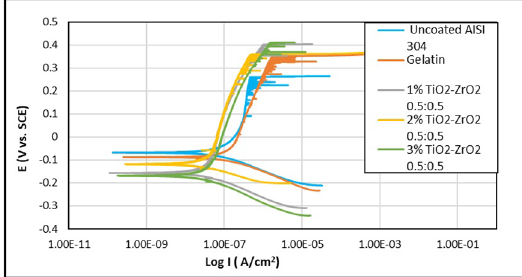
Figure 9. The potentiodynamic polarization curves of the AISI 304 steel coated with hybrid TiO -ZrO coating with mix ratio 0.5:0.5 2 2 and different weight percentages (1% wt., 2% wt., 3% wt.) of nanoparticles dispersed in gelatin.